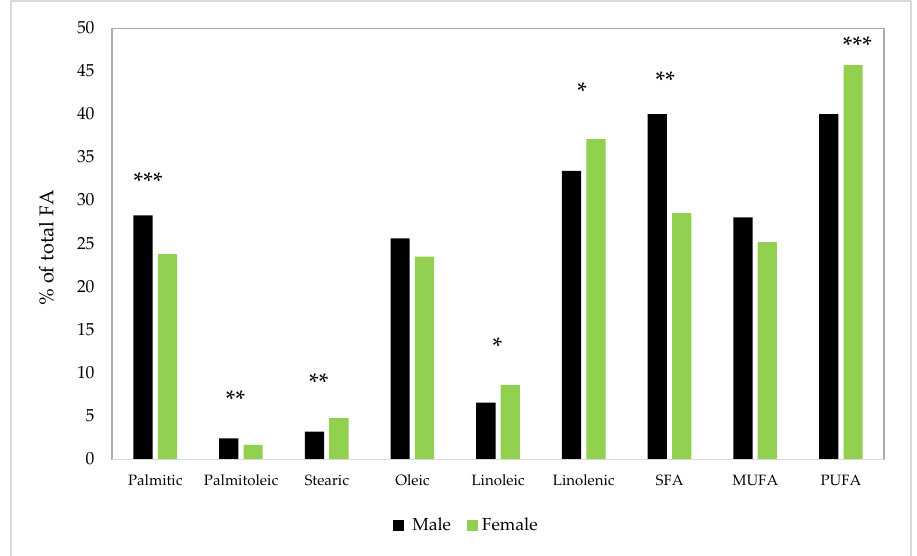
Figure 4. Average FA concentrations in SP throughout the entire developmental cycle, depending on sex; nonsignificant effect for oleic and MUFA FA; * p < 0.05 significant difference between means; ** p < 0.01 and *** p < 0.001 highly significant difference between means.